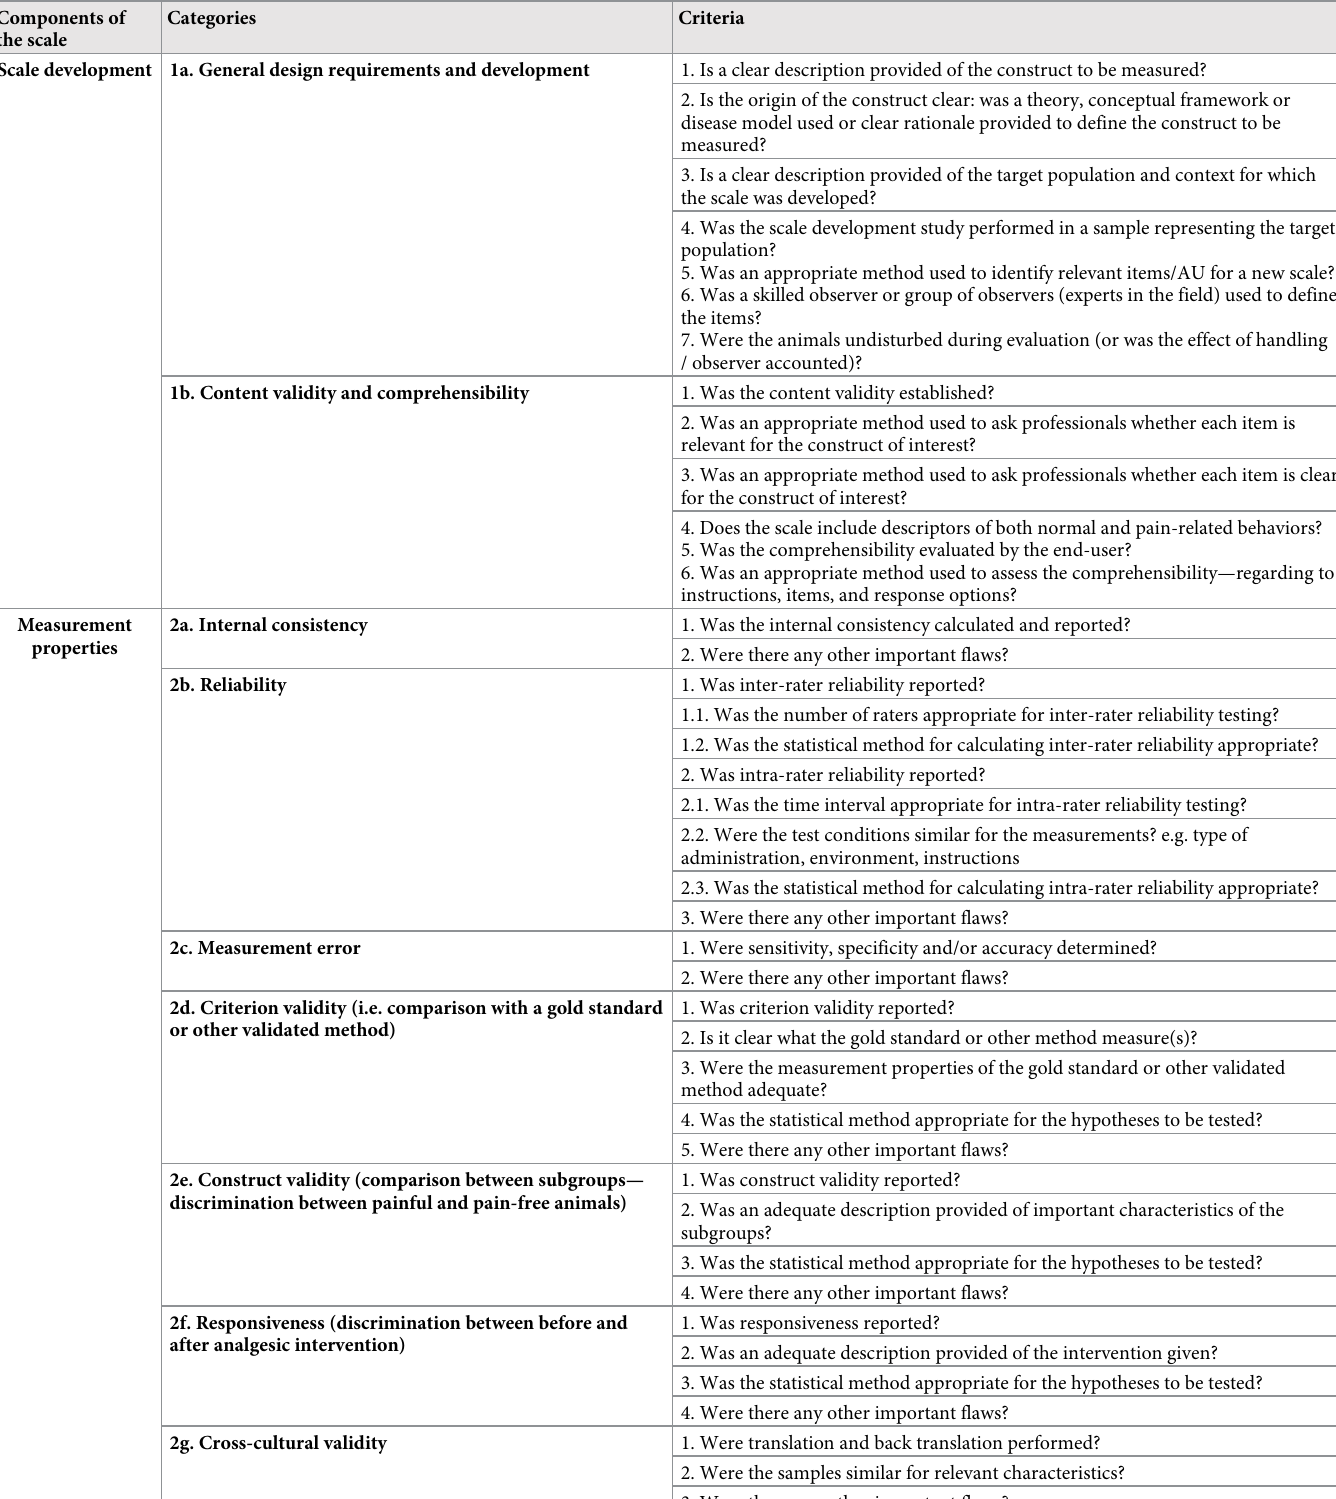
Table 1. Criteria used for assessment of methodological quality (Part A). Adapted from the Consensus-based Standards for the Selection of Health Measurement Instruments (COSMIN) [38, 41, 45, 47]. Components of the